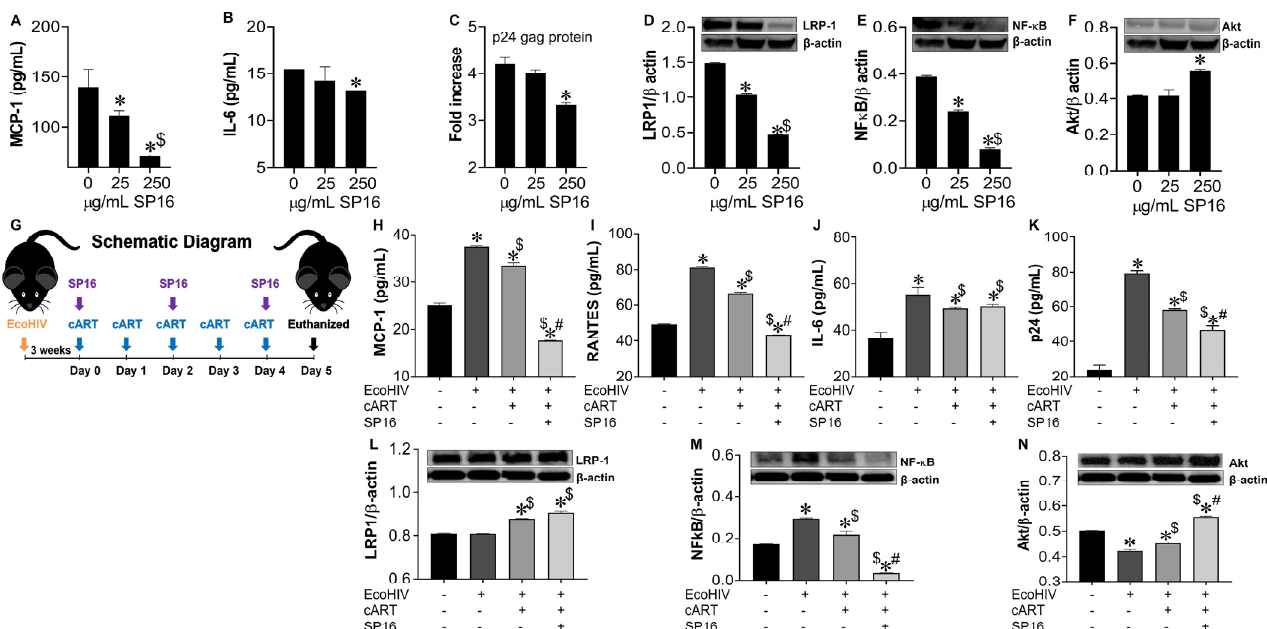
Figure 9. SP16 induces anti-inflammatory and anti-viral responses in EcoHIV-infected mouse brain. Supernatant was collected after 24 h post treatment and used to measure the secretion of inflammatory molecules ( A , B ) and viral titer ( C ) by ELISA. LRP-1 ( D ), NF- κ B ( E ), and Akt ( F ) protein expression levels were measured by immunoblotting. Results are reported as the mean ± SEM of 3 independent experiments. Data were analyzed using one or two-way ANOVA analysis followed by Dunnett multiple comparisons. A value of p < 0.05 was considered significant. * vs. media; $ vs. 25 μ g/mL SP16. Brains of adult mice (N = 3–5/treatment) were collected at necropsy. EcoHIV Infected animals received cART alone and in combination with SP16 (as illustrated in schematic diagram G ). Homogenized brain lysates were used to measure secretion of inflammatory molecules ( H – J ) and viral titer ( K ) by ELISA. LRP-1 ( L ), NF- κ B ( M ), and Akt ( N ) protein expression levels were measured by immunoblotting. Data were analyzed using one or two-way ANOVA analysis followed by Dunnett multiple comparisons. A value of p < 0.05 was considered significant. * vs. PBS control; $ vs. EcoHIV; # vs.